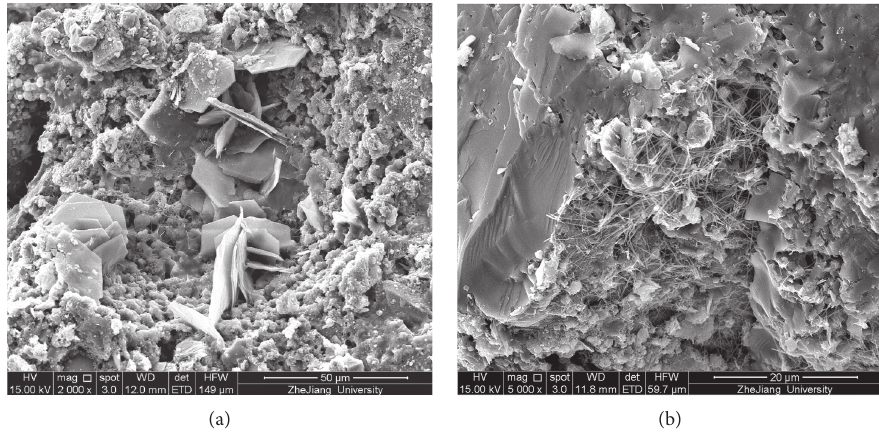
Figure 6: Enlarged view of hydration products.